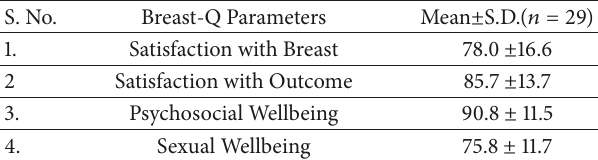
Table 4: PROMs from EO study